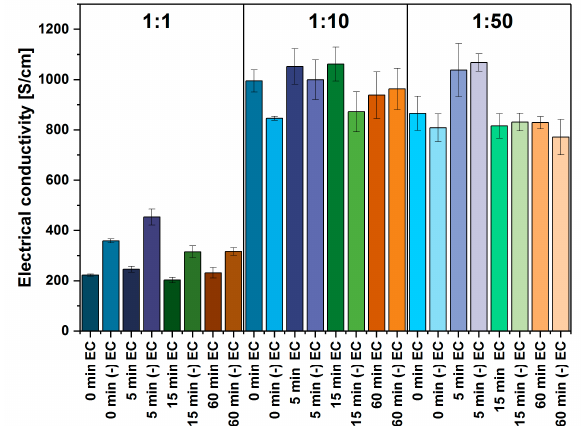
Figure 6. The influence of grinding time and EC content on electrical conductivity (before and after EC removal indicated with (-)